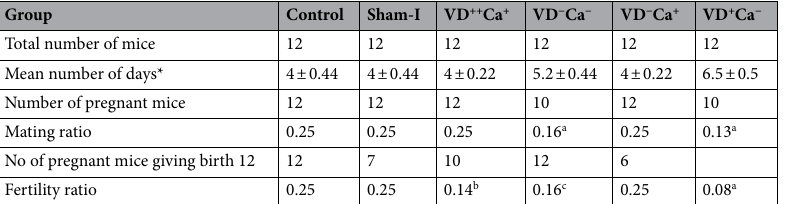
Time lag between mating/parturition, pup number and survival in the different animal groups. Assuming that the estrous cycle and gestation last 4–5 days and 18–21 days, respectively, a normal time from mating to parturition of about 22–26 days can be expected. This is consistent with the values obtained in the control and sham animal groups (23 and 23.1 days, respectively). In the group of mice VD overdosed (Fig. 3A). In contrast, in the group of VD deficient animals with hypo-calcemia (VD − Ca − ) this duration was